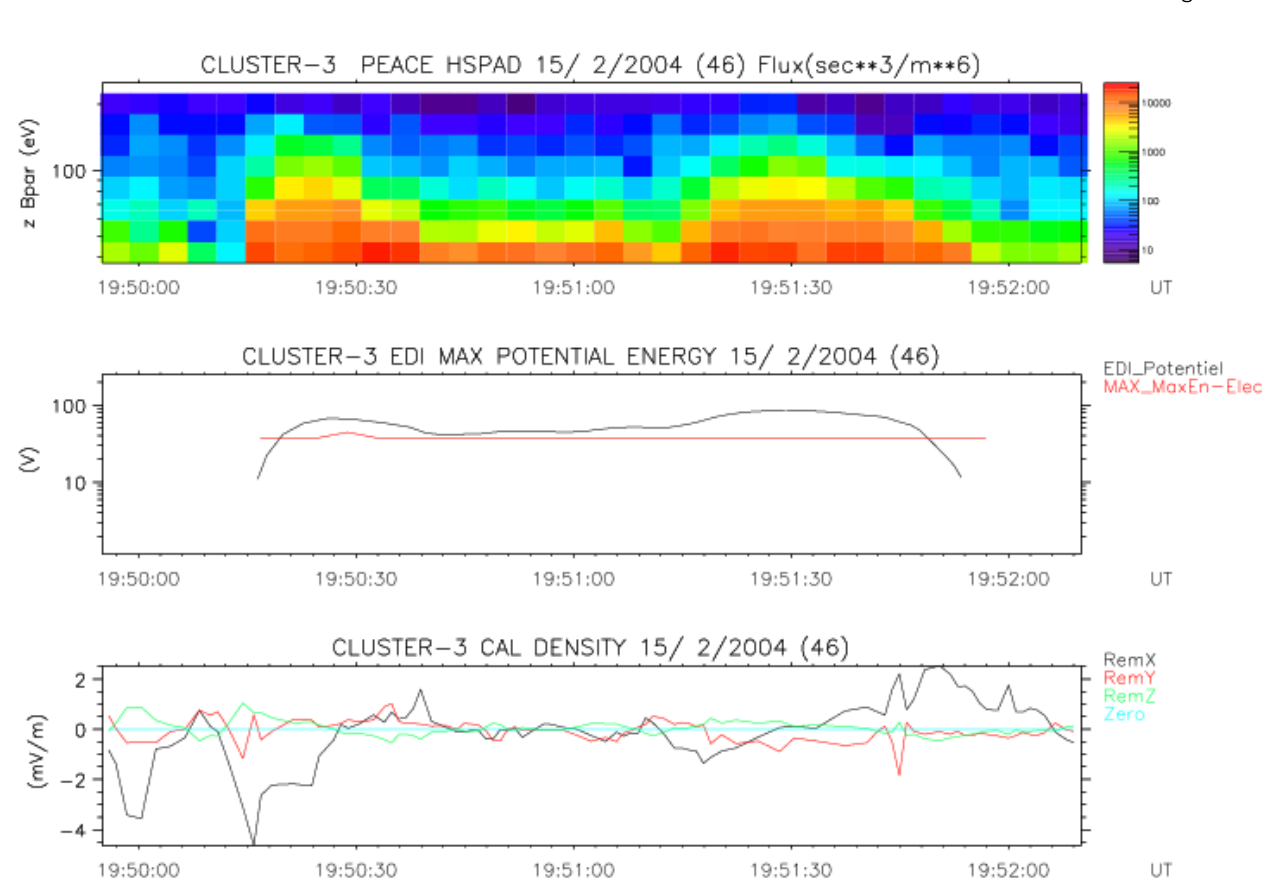
Fig. 10. Top panel: Distribution function spectrogram in the upward direction. Panel 2: Potential drops 8 Emax , computed from the energy of the distribution function maximum (red curve), and 8 below s / c from the electric field component perpendicular to the magnetic field (black curve). Last panel: components 1Ex (black), 1Ey (red) and 1Ez (green) of the electric field variations 1 E ⊥ , in GSE